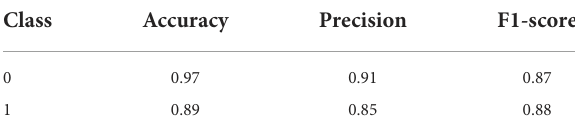
TABLE 4 Metric method to evaluate the